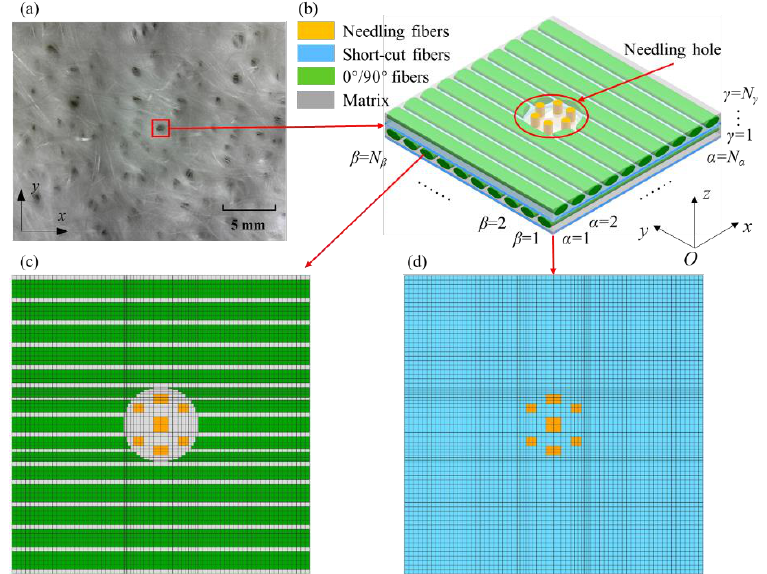
Figure 2. ( a ) Needling holes on the preform [37] ( b ) schematic diagram of a needling hole structure ( c ) GMC model of 0°/90° weftleshfps plies with a needling hole ( d ) GMC model of short-cut fibers with a needling hole.